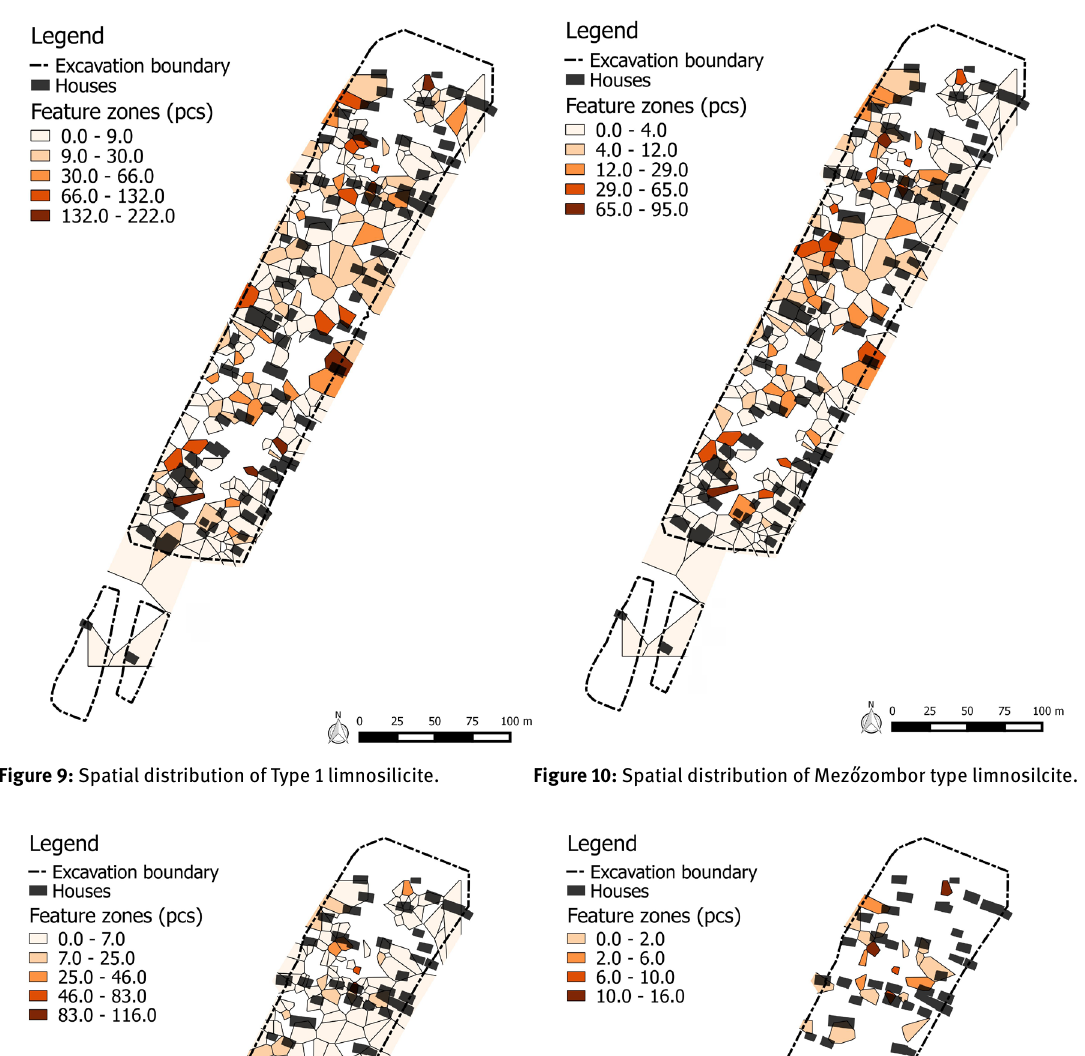
Figure 9: Spatial distribution of Type 1 limnosilicite. Figure 10: Spatial distribution of Mezőzombor type limnosilcite.